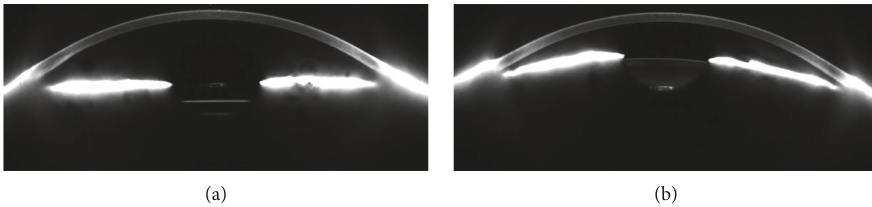
Figure 4: Example of Scheimp fl ug images of an intraindividual comparison of a pseudophakic right eye (a) and a phakic left eye (b) in the GHS study population. Please observe the di ff erent light re fl exes by the arti fi cial intraocular lens and the crystalline lens. The iris is fl at in the pseudophakic eye (a), while it is positioned towards the cornea in the phakic eye (b). This is described by iris conicity: iris conicity was − 1 ° in the pseudophakic eye and 11 ° in the phakic